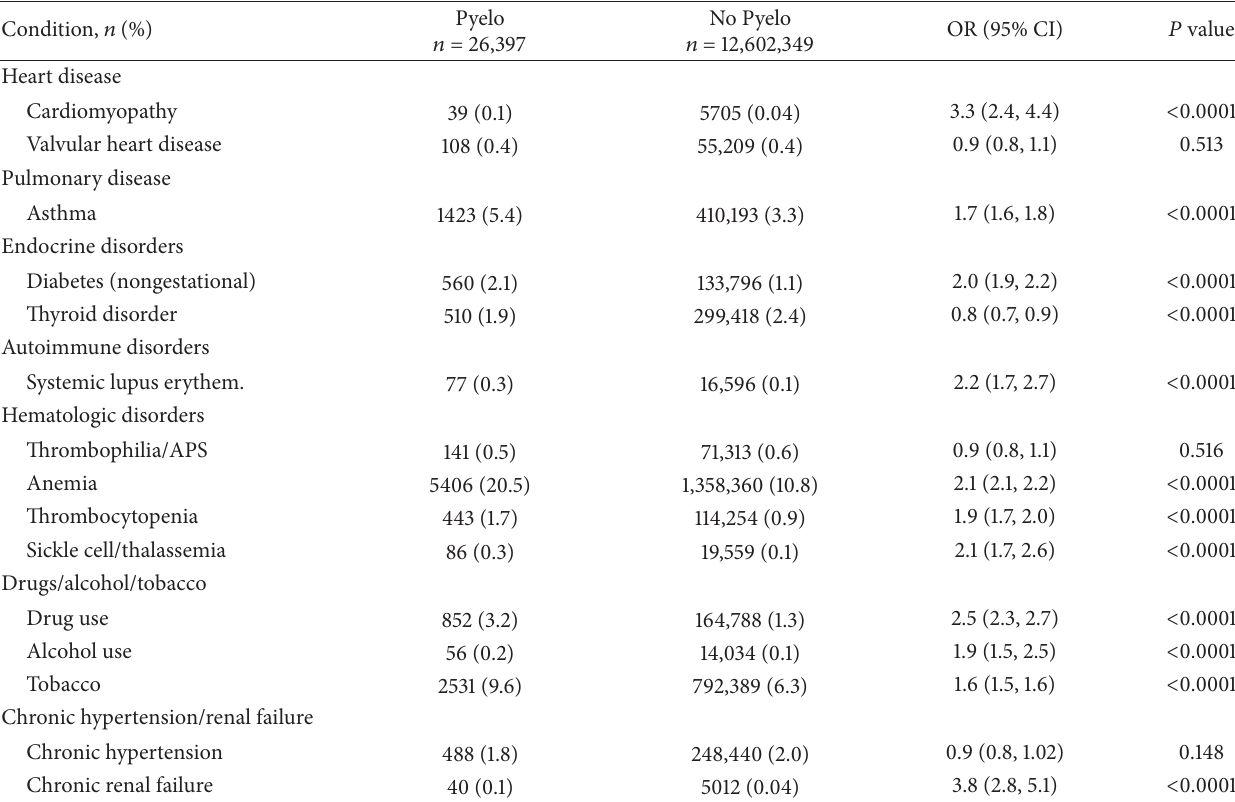
Table 2: Preexisting medical conditions present at time of delivery in hospital discharges among women with pyelonephritis compared to women without pyelonephritis, Nationwide Inpatient Sample years 2008–2010 (12,628,746